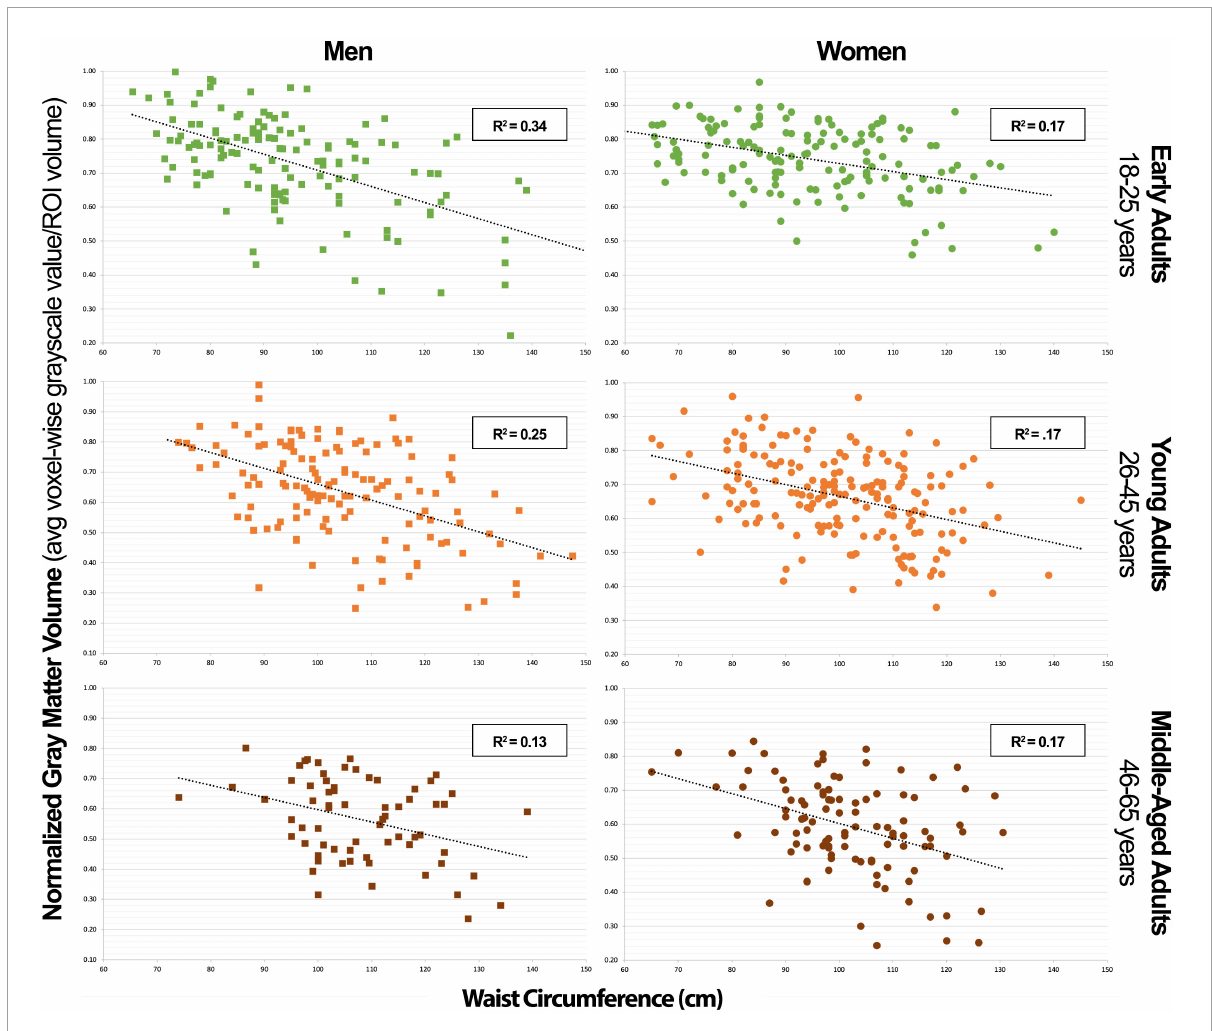
FIGURE4 Posterior cerebellar gray matter volume vs. waist circumference scatterplot